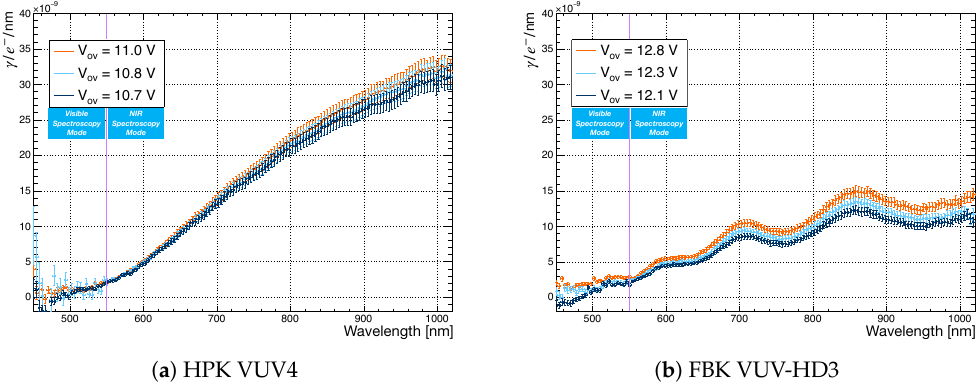
Figure 7. Spectra of the HPK VUV4 and FBK VUV-HD3 SiPMs as a function of the applied over-voltage.